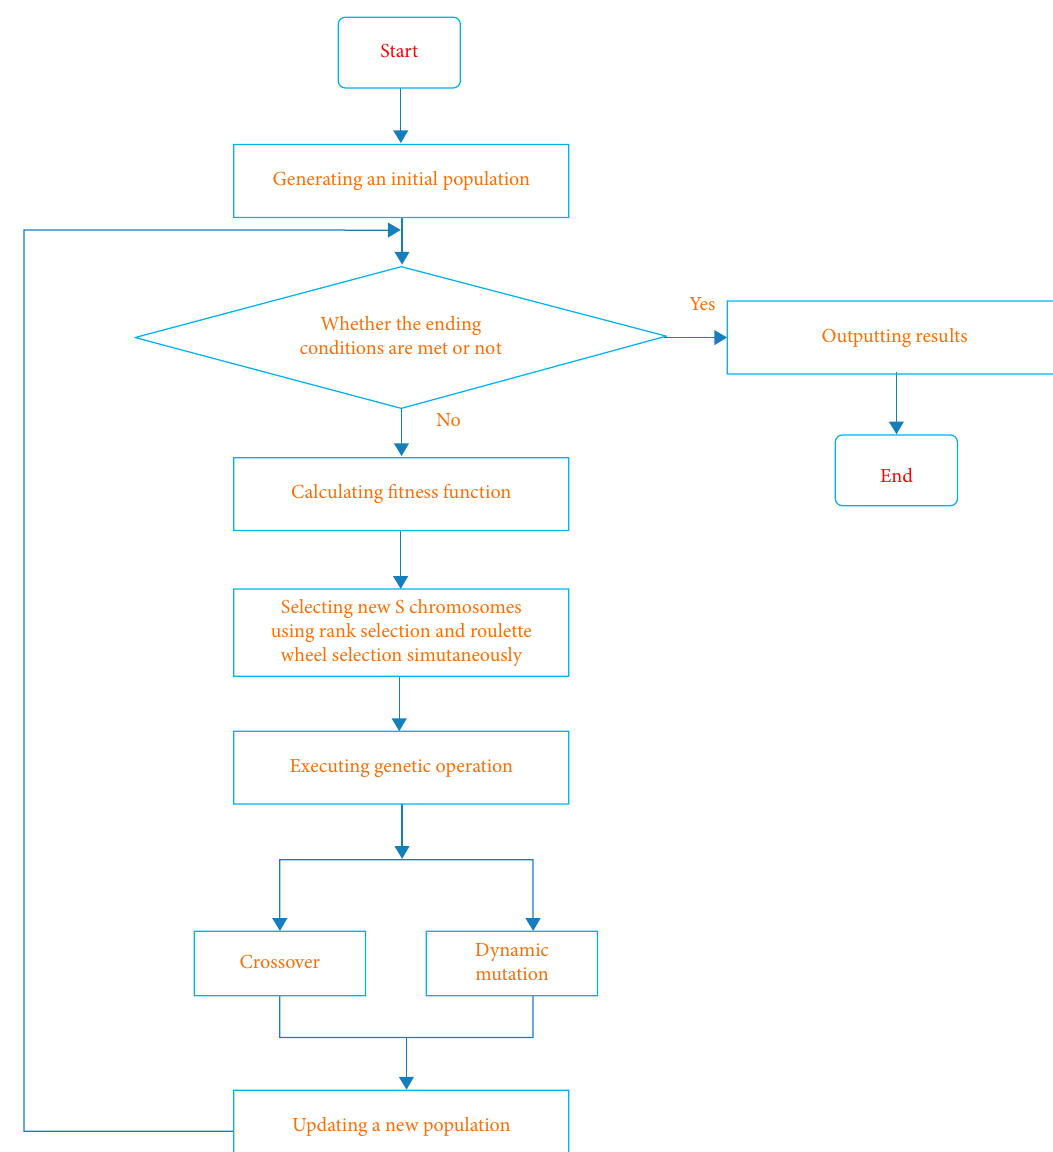
Figure 2: The general framework of the genetic